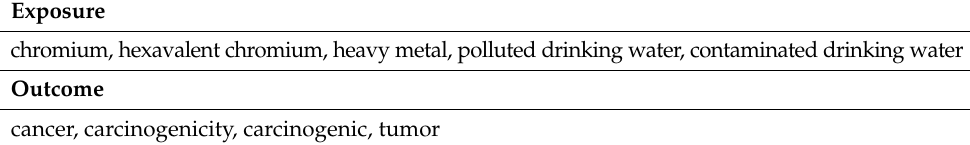
Table 2. Keywords for searching relevant studies on online databases. Exposure